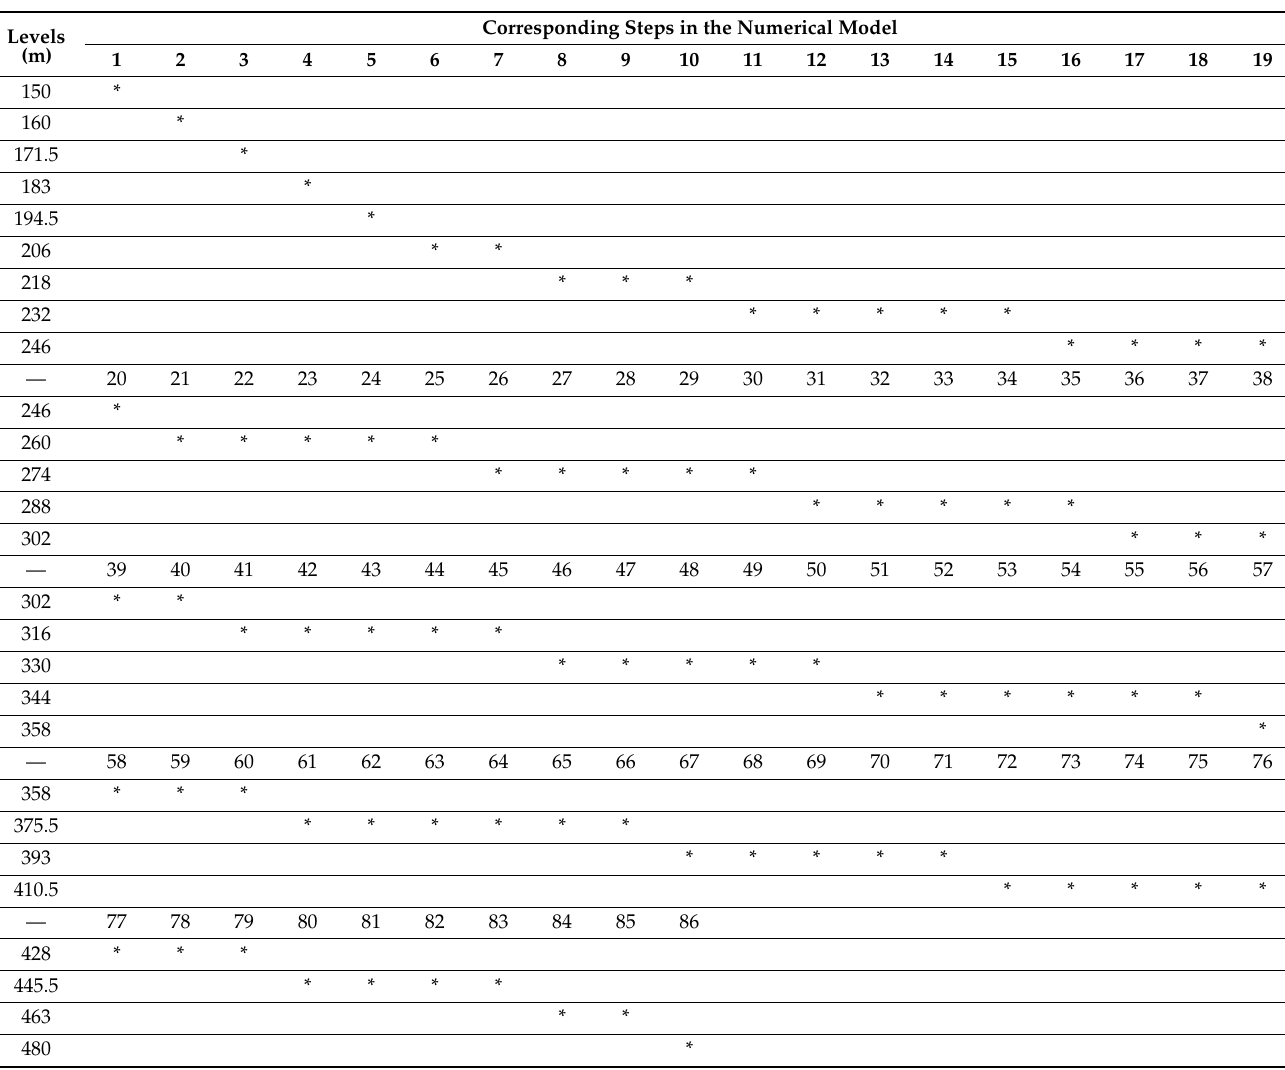
Table 2. Relationship between excavation steps and mining levels in the numerical model.